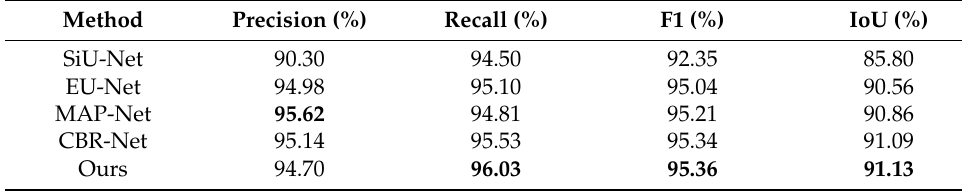
Table 5. Quantitative comparison of MEC-Net using the WHU dataset.